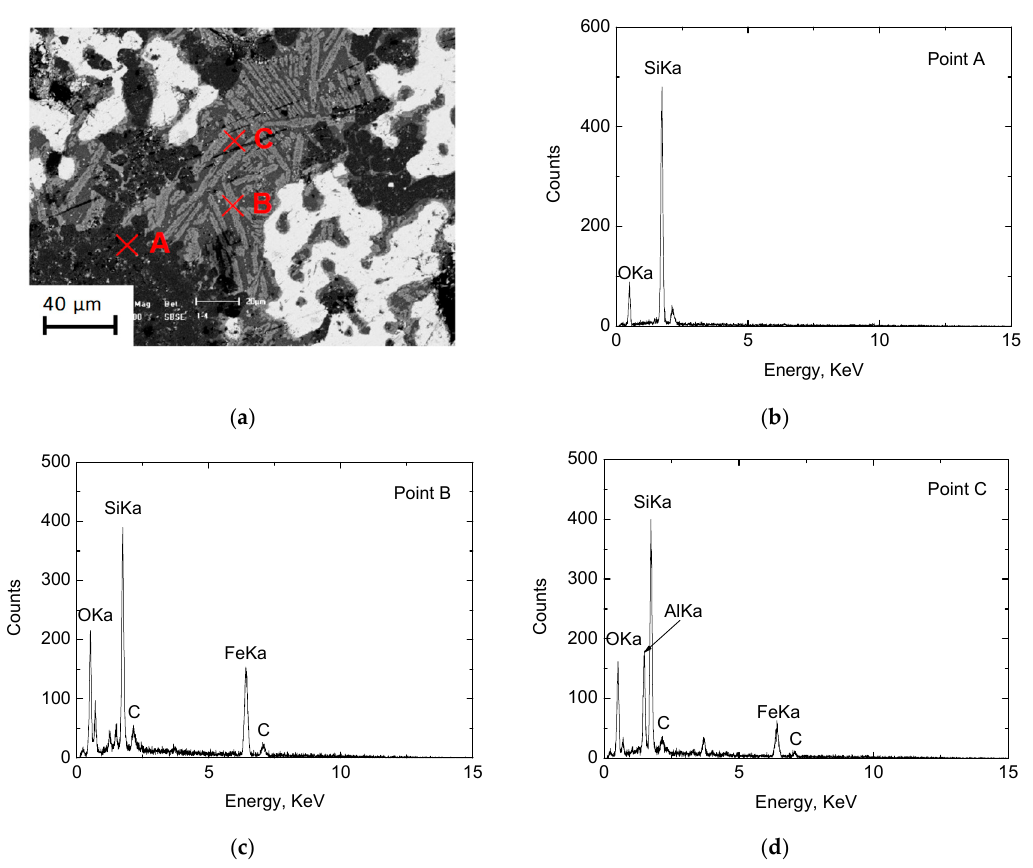
Figure 12. Metallographic picture and energy spectrum of the 1st layer direct reduced iron (DRI) reduced for 60 min: ( a ) metallographic picture; ( b ) point A; ( c ) point B; ( d ) point C.